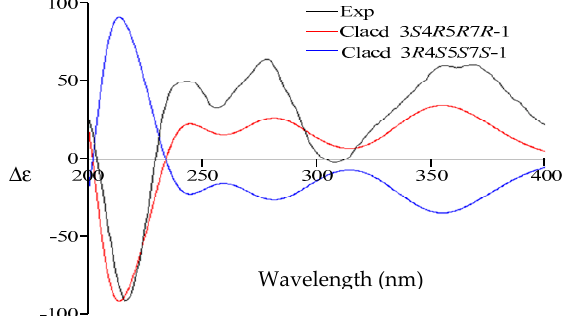
Figure 4. Comparison of the experimental ECD spectrum of 1 (black) with those calculated for the enantiomers 3 S 4 R 5 R 7 R (red) and 3 R 4 S 5 S 7 S (blue). (UV correction = ´ 13 nm, bandwidth σ = 0.26 Table 1. NMR spectroscopic data for compound 1 (DMSO- d 6 ) a .